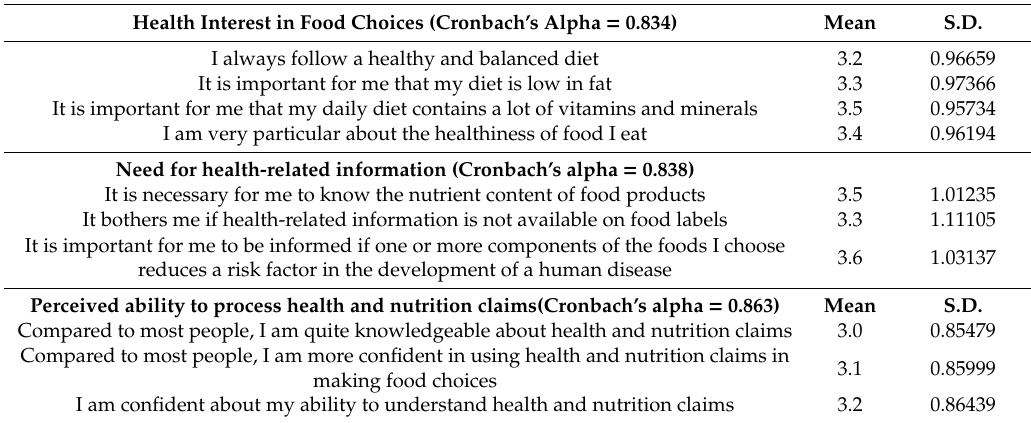
Table 2. Motivation and ability to process nutrition and health claims